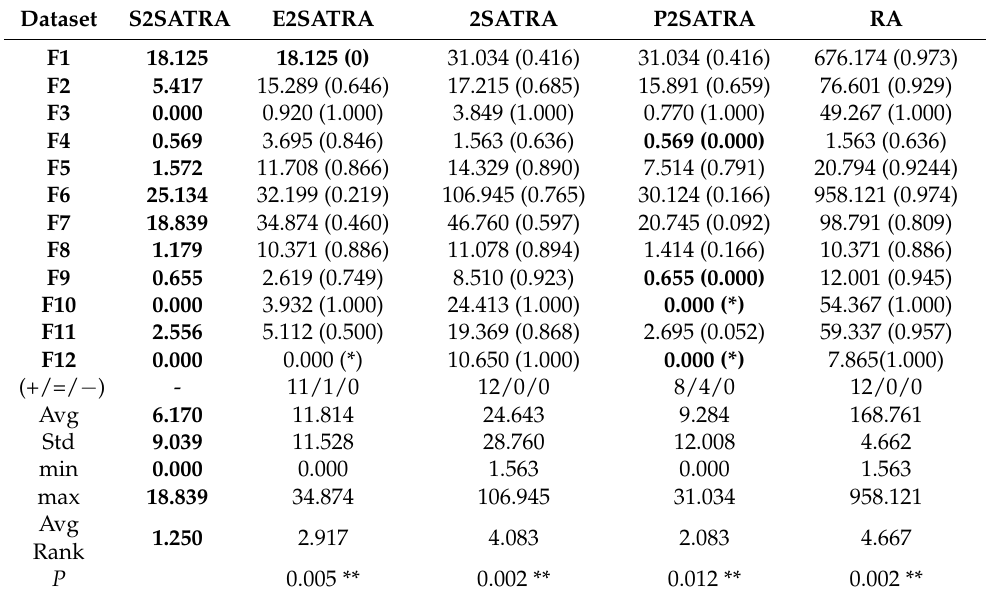
Table 9. RMSE for all logic mining models. The bracket indicates the ratio of improvement and * indicates division by zero. A negative ratio implies the method outperform the proposed method. P is obtained from the paired Wilcoxon rank test and ** indicates the model with significant inferiority compared to the superiority model.